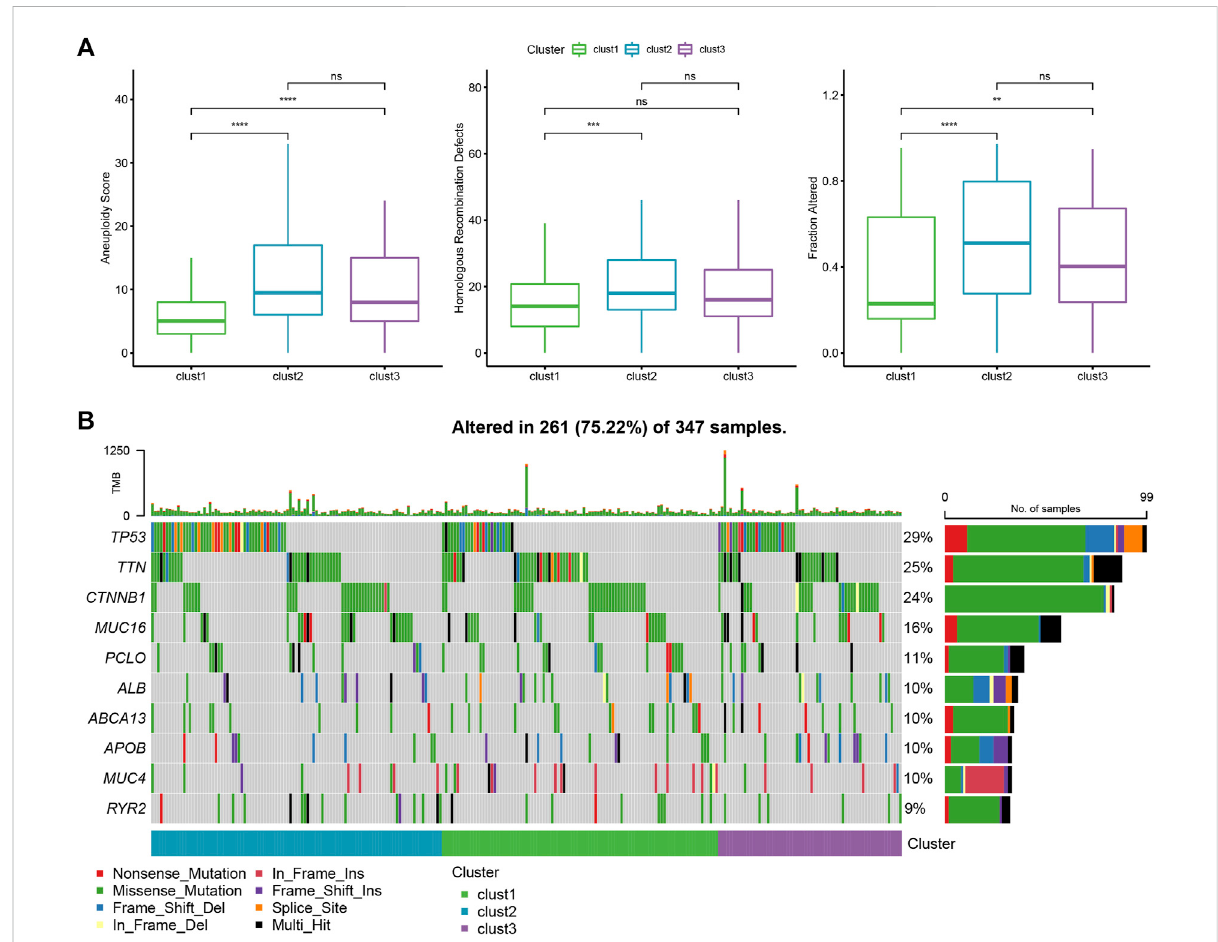
FIGURE 3 Genome changes of molecular subtypes in the TCGA-LIHC dataset. (A) The differences among the molecular subtypes of the TCGA-LIHC dataset werecompared intermsof Aneuploidy Score, Homologous RecombinationDefects,Fraction Altered. (B) The top10 mutated genes